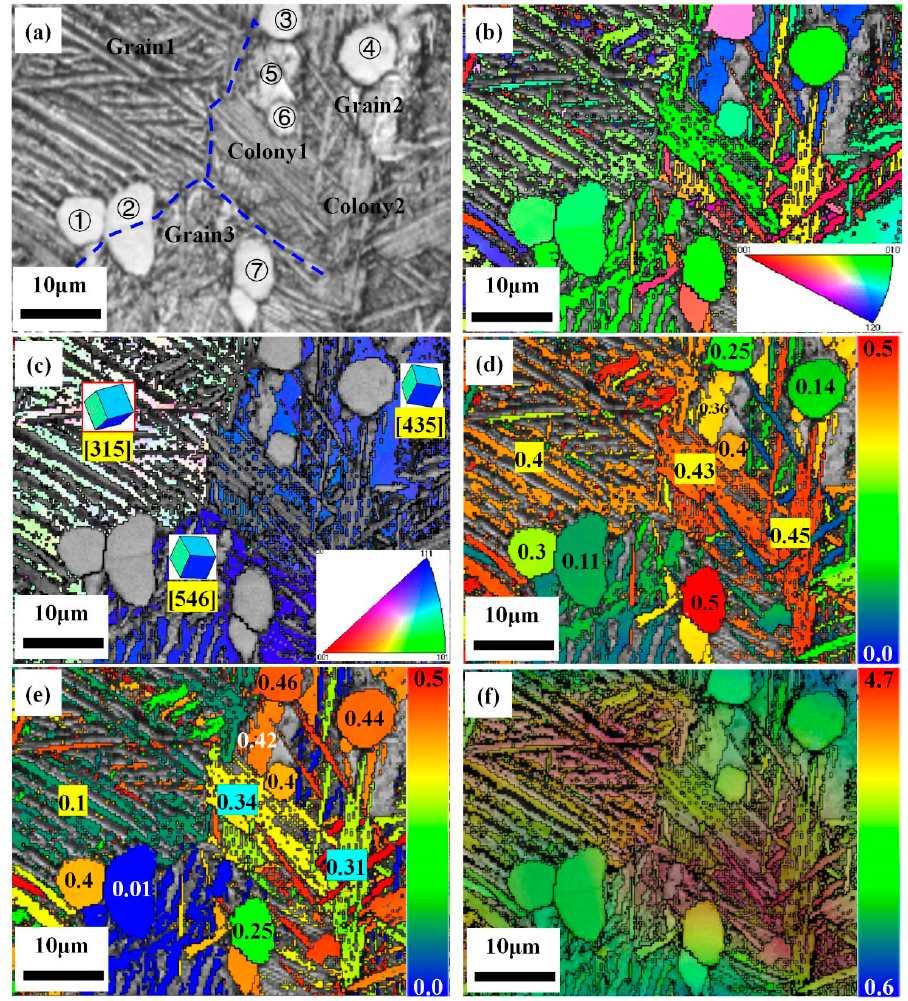
Figure 6. The plastic deformation and strain distribution in front of the main crack: ( a ) the α p particles located at the grain boundary; ( b ) the inverse pole figure (IPF) map of the α phase; ( c ) the IPF map of the β phase; ( d ) the Schmid factor of basal slip of the α phase; ( e ) the Schmid factor of prismatic slip of the α phase; ( f ) the strain distribution near the grain boundary.